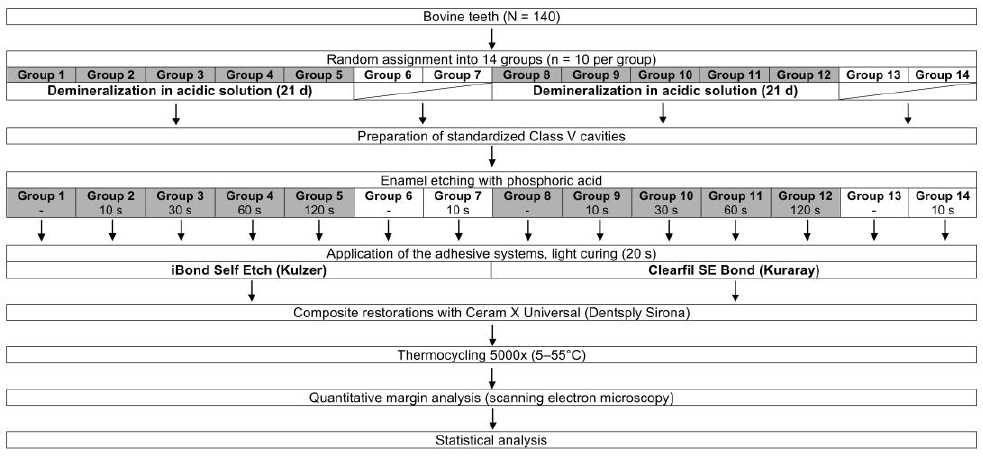
Figure 1. Experimental design.